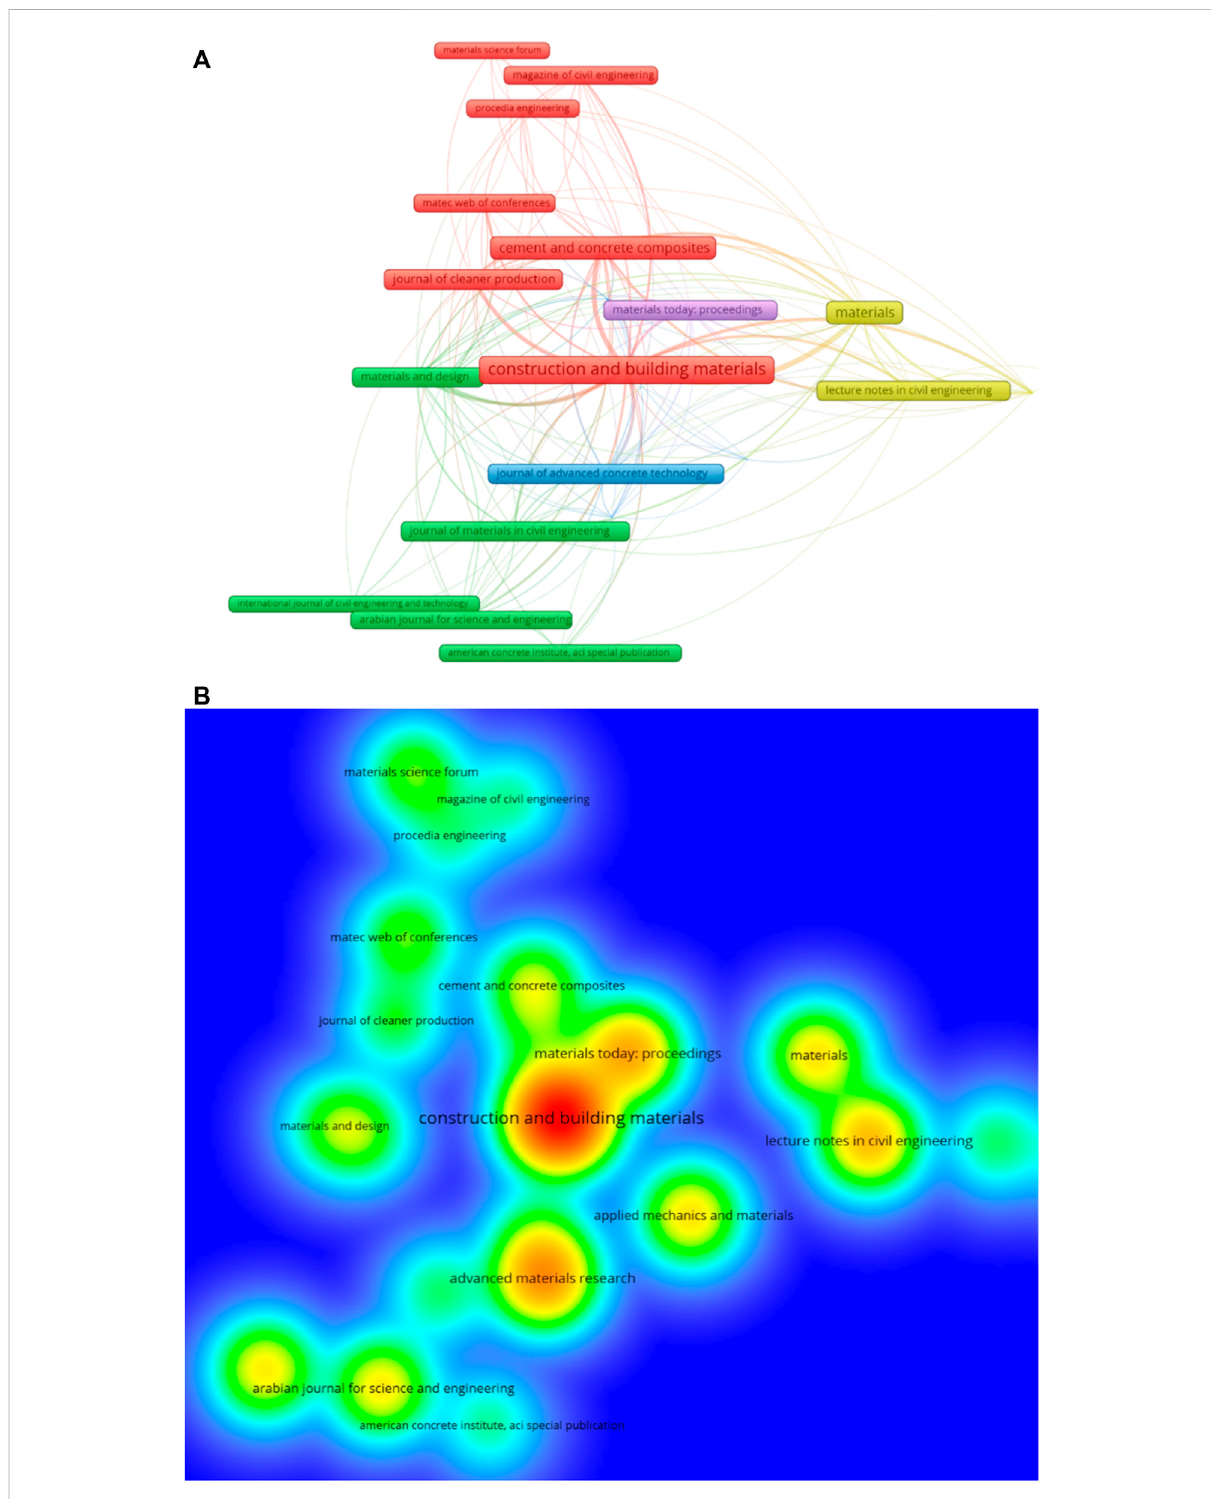
FIGURE 7 Mapping of sources having at least 10 publications. (A) Network visualization; (B)